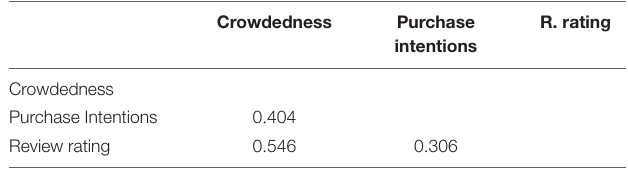
TABLE 3 | Fornell-Larcker criterion. TABLE 4 | Heterotrait-Monotrait ratio